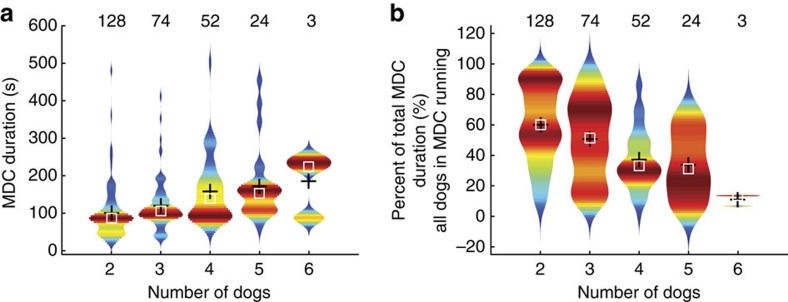
Total duration and simultaneous run duration of MDCs.(a) Total MDC duration versus number of dogs involved (time from when first dog starts running until last dog stops running). (b) Percentage of time during which all dogs participating in MDCs are running simultaneously. Number of runs in each group size displayed above each kernel histogram: total number of MDCs, n=278; total number of runs in all MDCs, n=382.